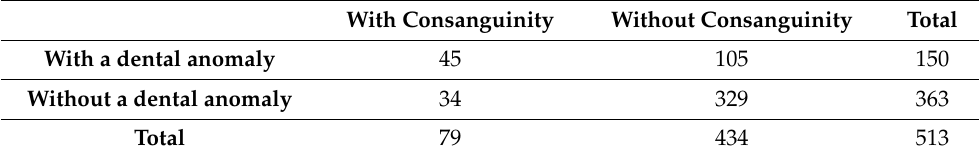
Dental anomalies were found in 66.67% (24) of the 36 males with relative marriages whereas they were present in only 31.45% (50) of those who did not have any consanguinity. The group of females had similar findings. Dental anomalies were found in 48.84% (21) of the 43 females with relative marriages, whereas it was present in only 20% (55) of females who did not have any consanguinity. The results are shown in Figure 5.